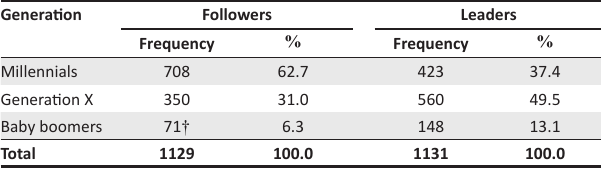
TABLE 2: Count: Followers and leaders.